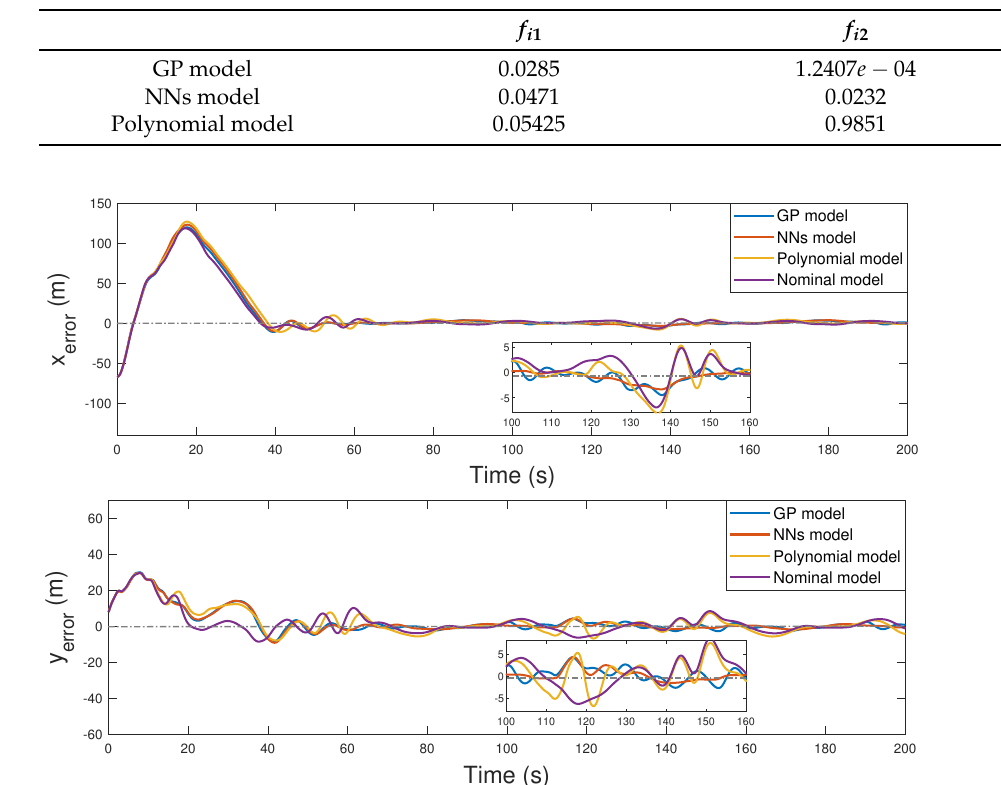
Figure 7. Accumulated consensus tracking errors of 4